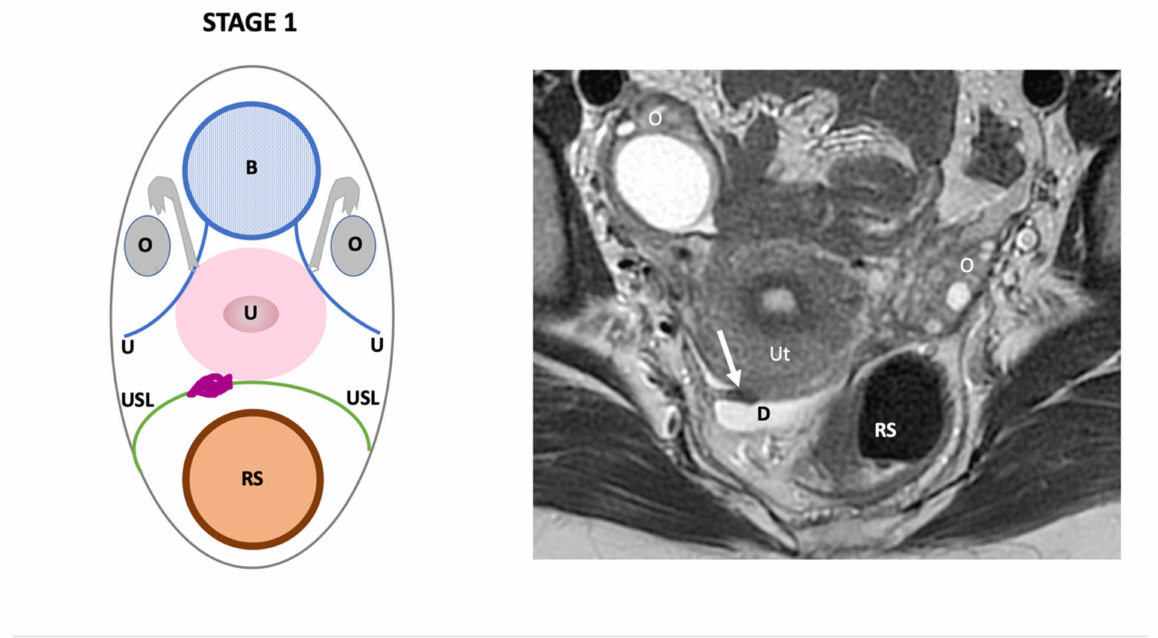
Figure 2. Schematic and example of stage I Endo-Stage MRI classification showing the presence of an irregular thickening of the right uterosacral ligament (arrow) with low signal intensity on a T2- weighted MRI underlined by a small amount of fluid in the pouch of Douglas ( D ). Note: ( B ): bladder, ( RS ): rectosigmoid colon, ( O ): ovary, ( U ): ureter, ( USL ): uterosacral ligament, ( Ut ): uterus; red point: uterine